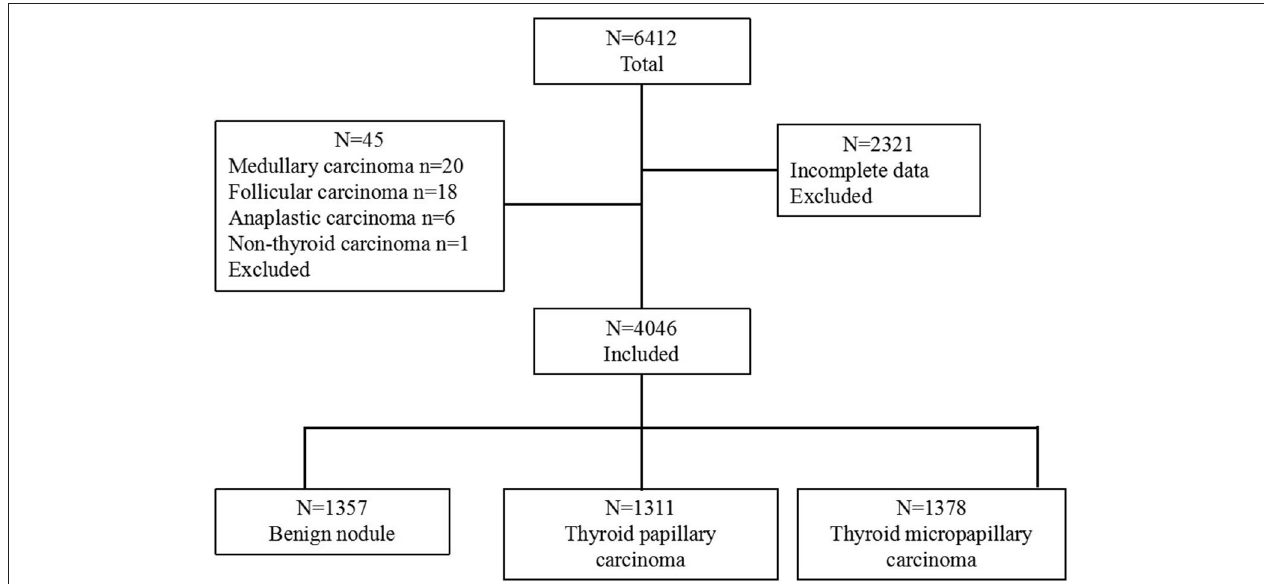
FIGURE 1 | Flow chart showing the categorization of 6,412 patients into 3 groups based on diagnosis. The group with 4,046 patients was further categorized into 3 pathological groups: benign nodule, thyroid papillary carcinoma, and thyroid micropapillary